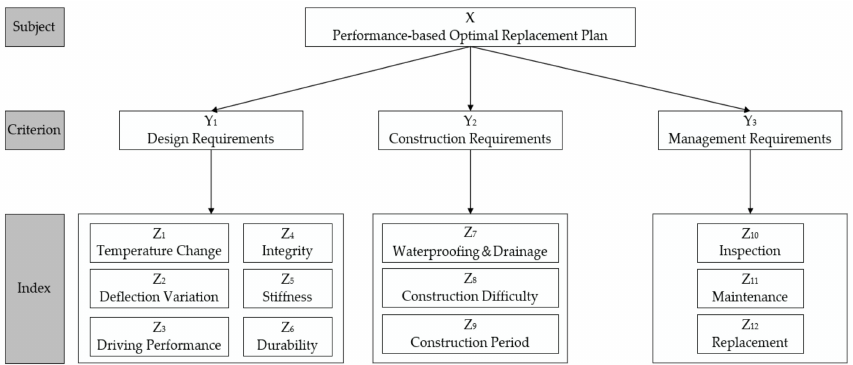
Figure 4. Hierarchy structure model of the performance-based replacement method selection.